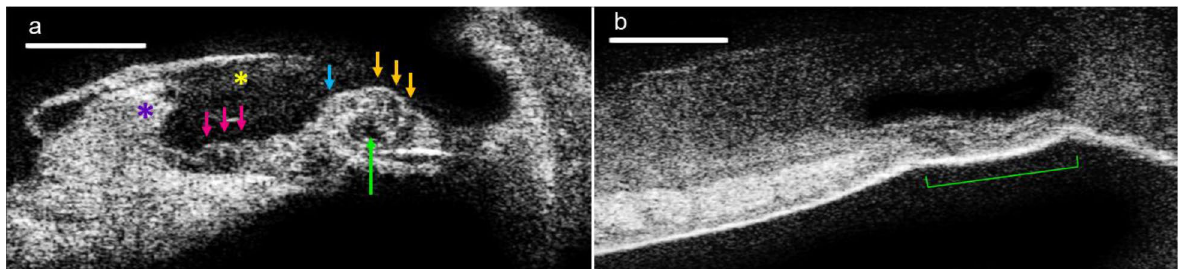
Figure 2. Mouse organs of Corti imaged using benchtop μOCT. ( a ) Organ of Corti dissected from the basal cochlear turn of a healthy mouse. Purple = spiral limbus; yellow = tectorial membrane; Arrows point to structures that are consistent with supporting and/or hair cells as evidenced by visualization of cell membranes. The ability to approximate cell type is given by their anatomical location: Pink, supporting cells; blue, inner hair cell; orange, outer hair cells. The green arrow demarcates the tunnel of Corti. ( b ) Organ of Corti dissected from the basal cochlear turn of a noise- exposed mouse. Flat epithelium morphology is marked with a green bracket. Scales = 100